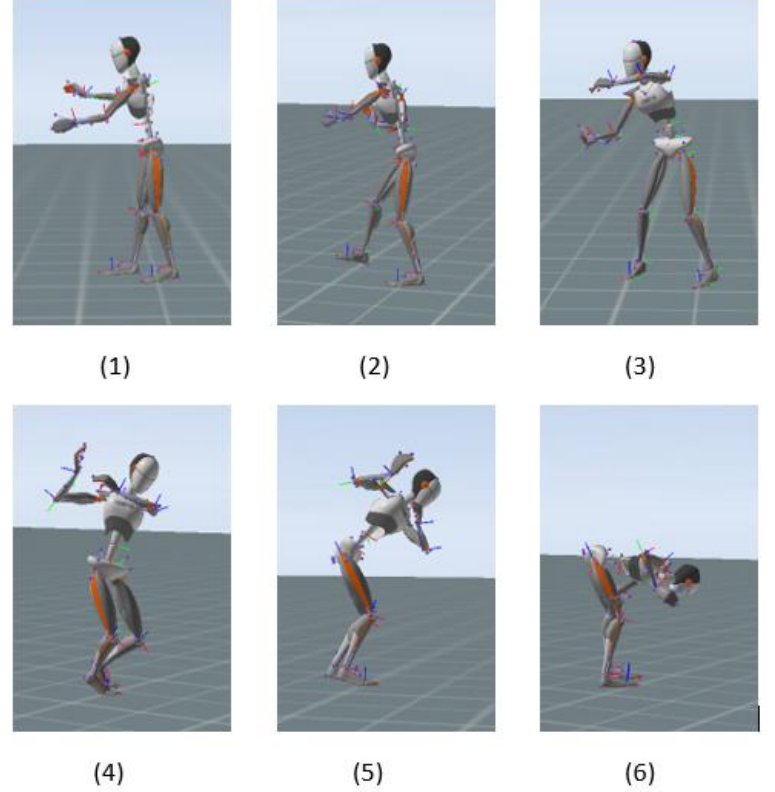
Figure 2. The performance of the ISN throw: ( 1 ) starting position; ( 2 ) kuzushi; ( 3 ) tsukuri; ( 4 ) tsukuri; ( 5 ) kake; ( 6 ) end of